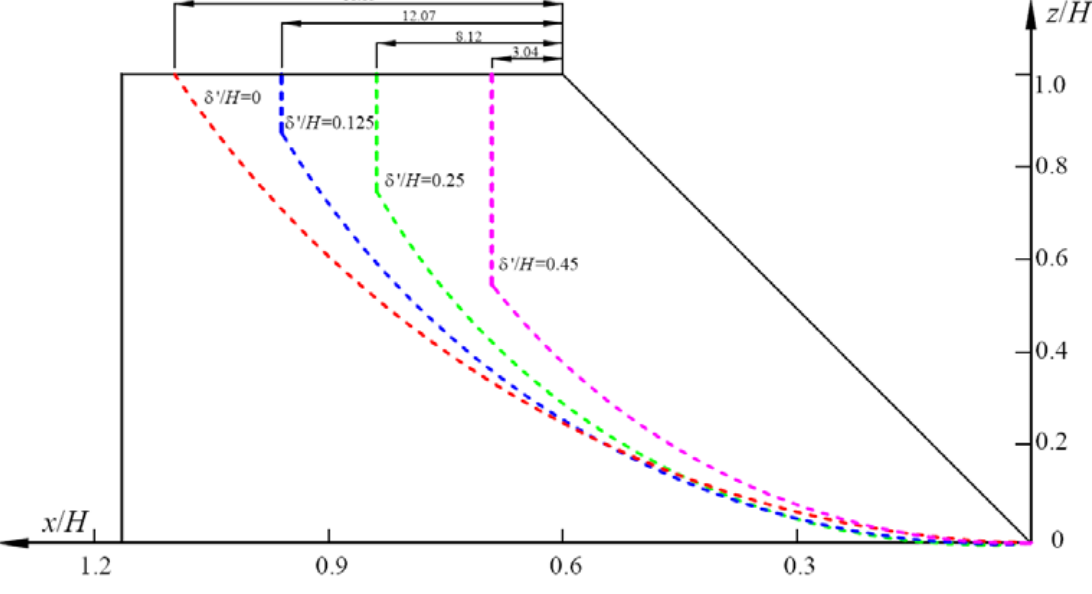
Figure 14. Slip body morphology and location of cracks for various values of δ ’ / H.